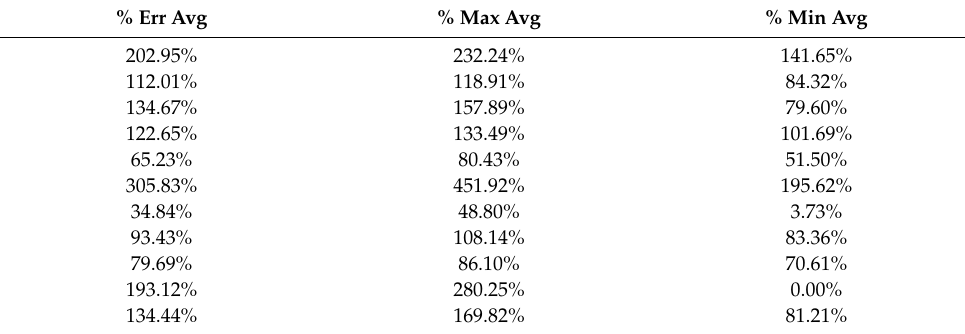
Table A136. Set 2, trials 31–40 data (average actual PR values).